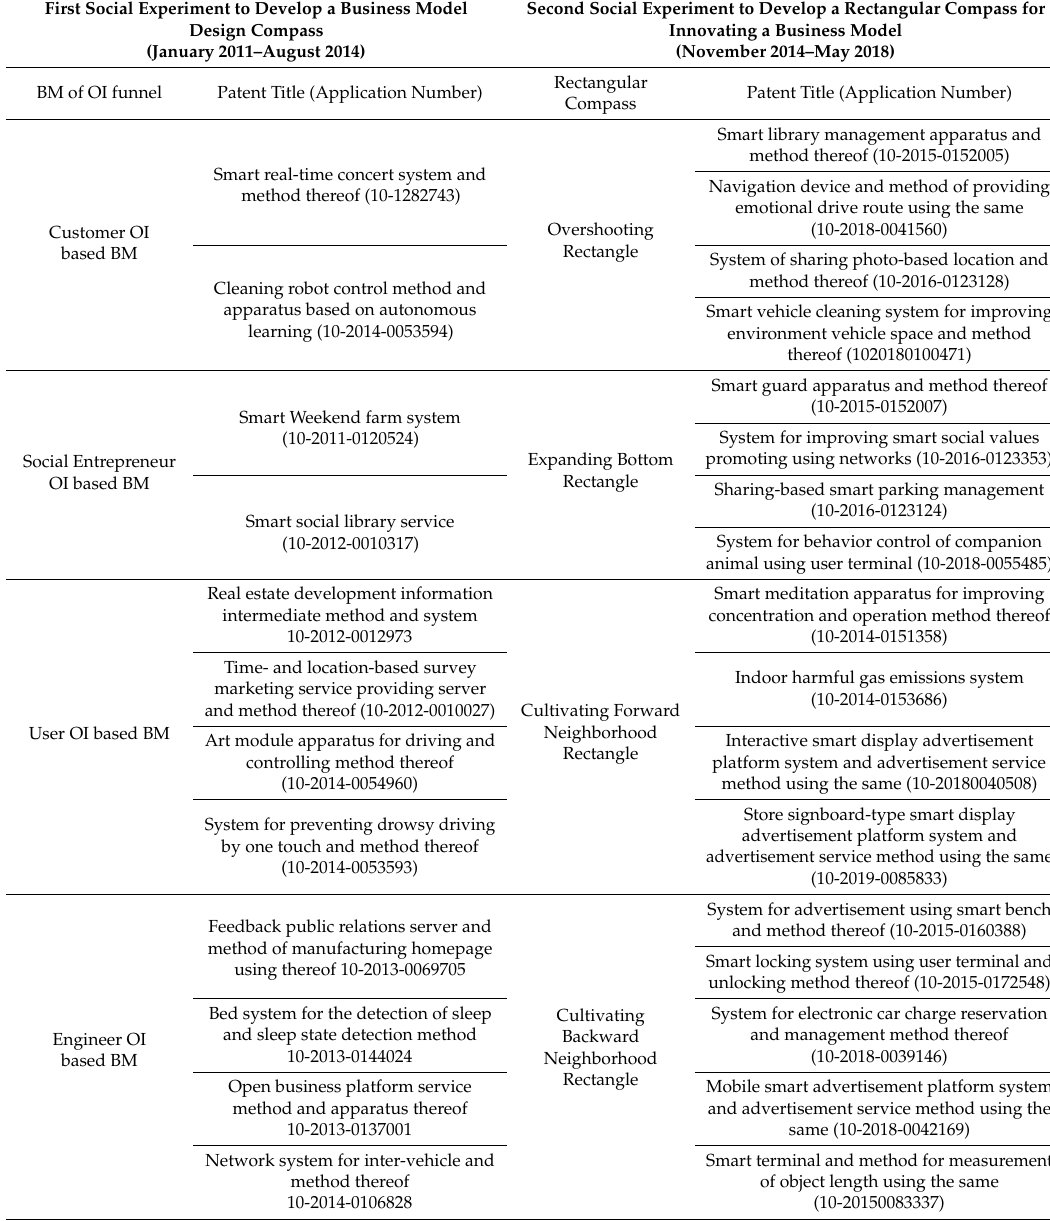
Table1. Socialexperimentwitharectangularcompass,